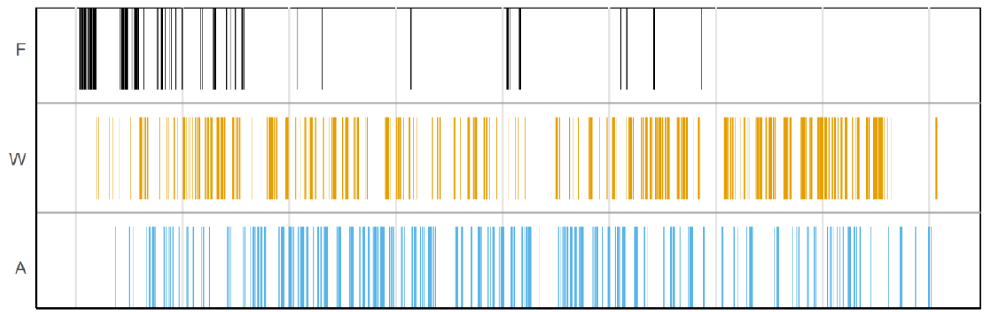
Figure 2. Distribution of turns in interview timeline by register: fusħa (F)/ wus ṭ a ː (W)/ ʕ a ː mijja (A).